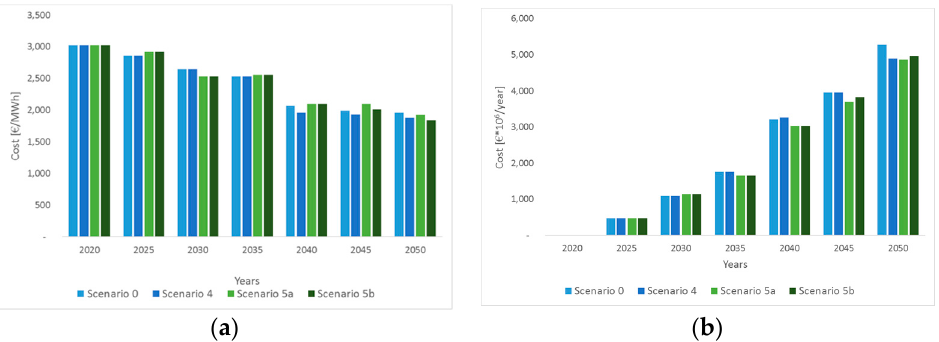
Figure 9. Evolution of the operational cost ( a ) and annualized investment cost ( b ) for Scenarios 4 and 5.